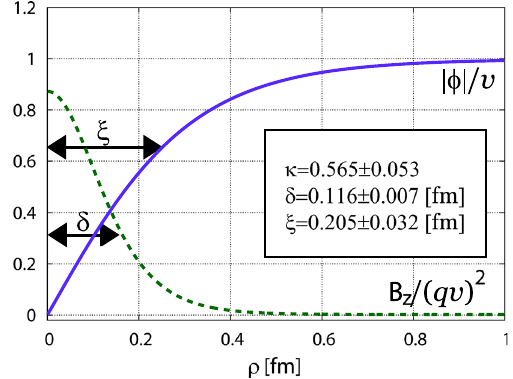
Fig. 8 The penetration and coherent lengths for the value of the fitted GL parameter κ = 0 . 565